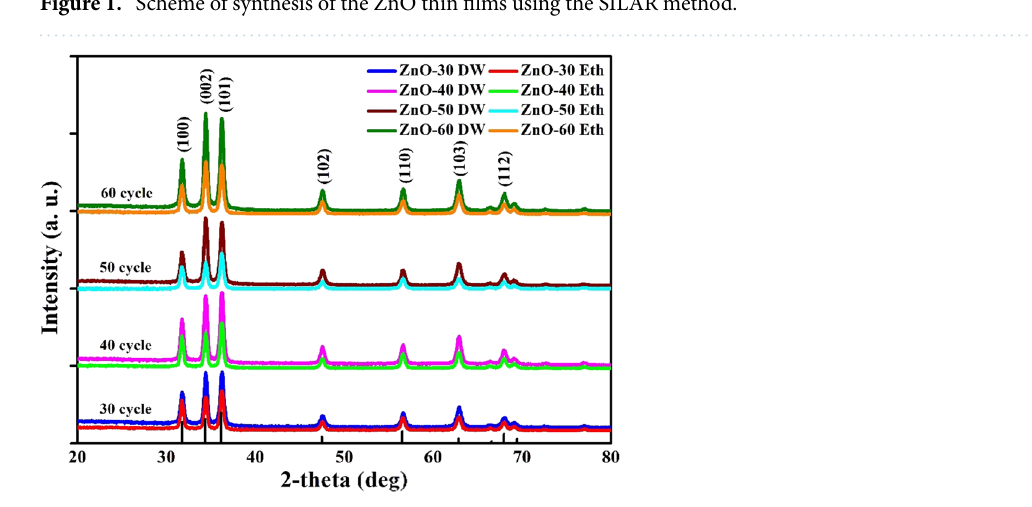
Figure 2. XRD patterns of ZnO thin films with different SILAR